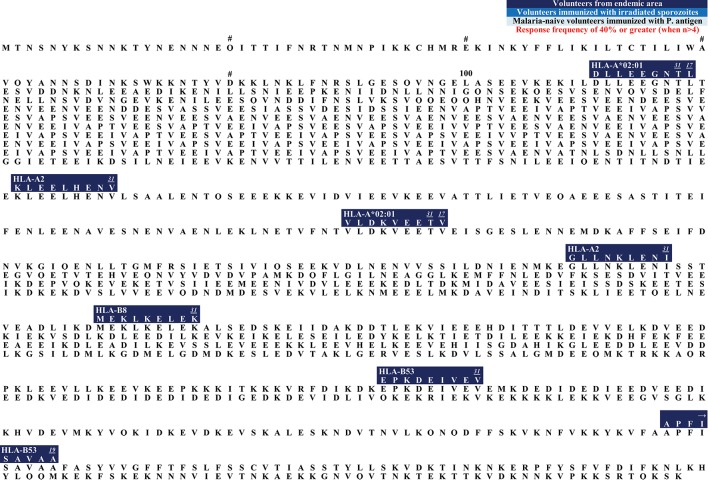
Epitope map of LSA3.